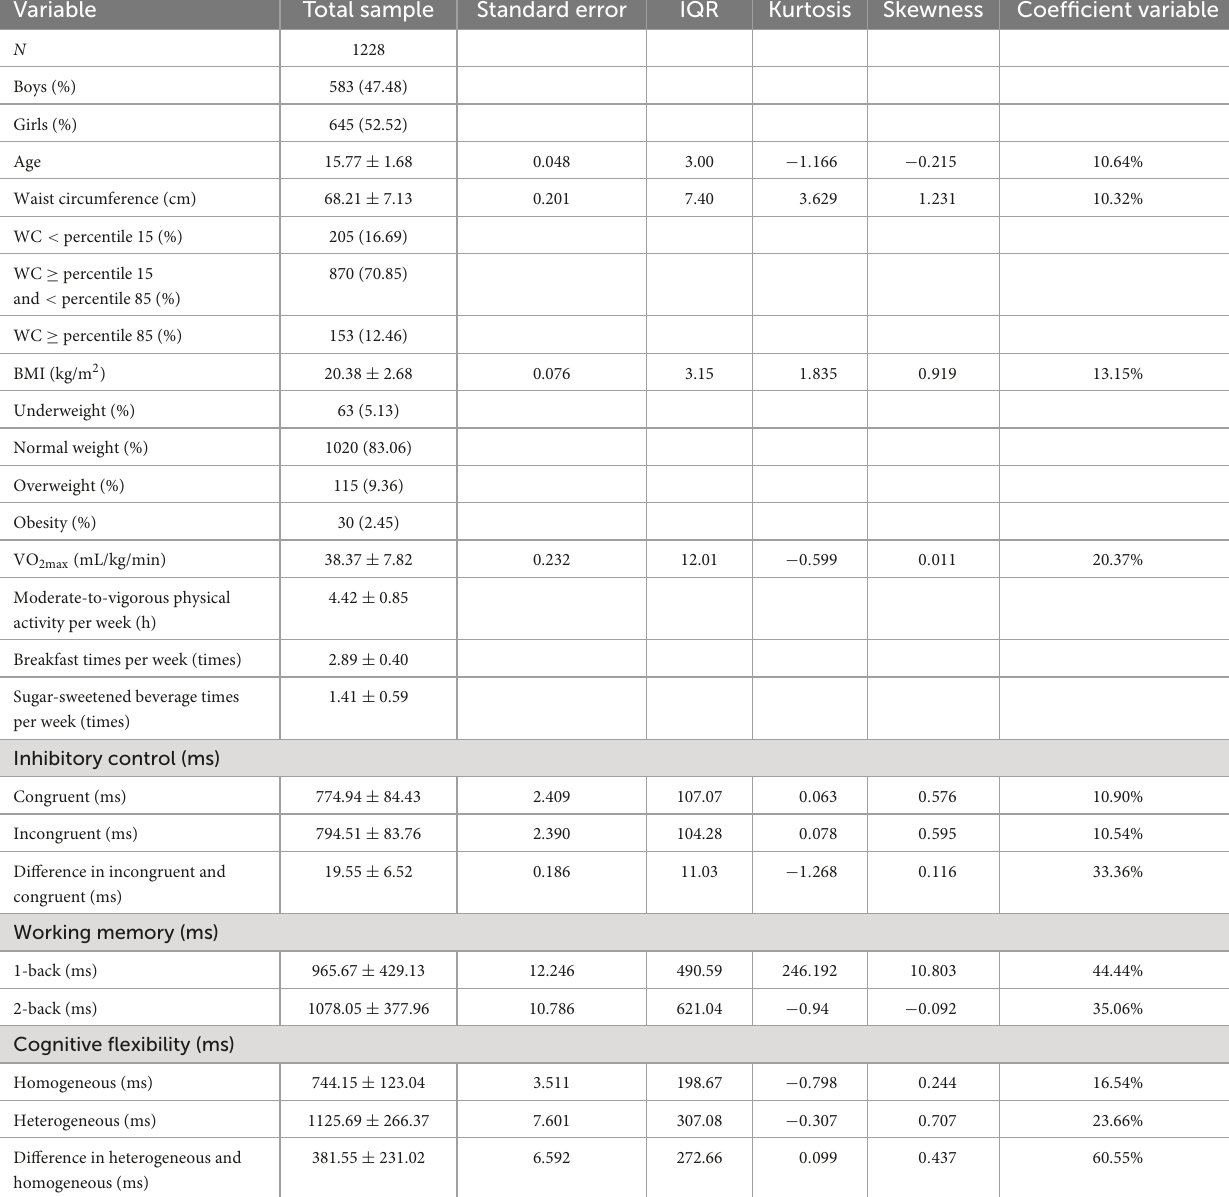
TABLE 1 Characteristics and assessments of adolescent